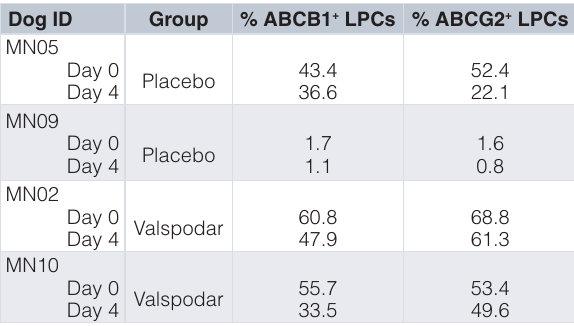
Table 5B. Valspodar-induced alterations in ABCB1 + and ABCG2 + LPCs in lymph node.